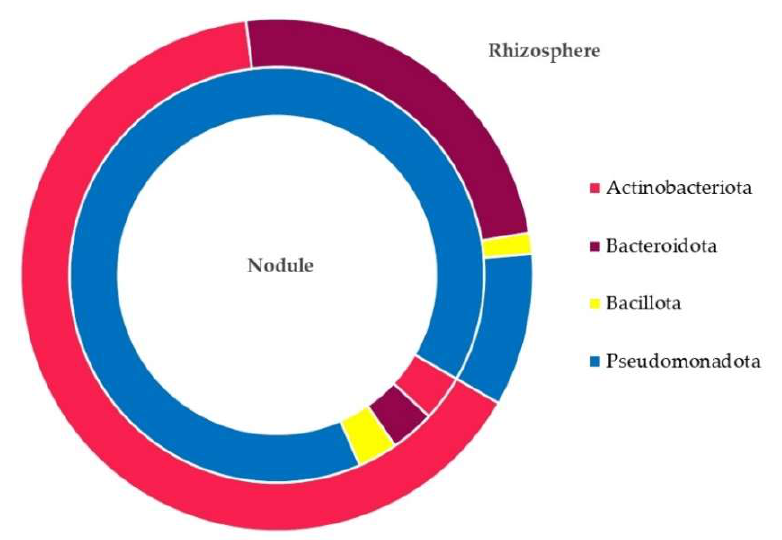
Figure 2. Amplicon sequence variants (ASVs) distribution at the phylum level in the nodule and rhizosphere samples.